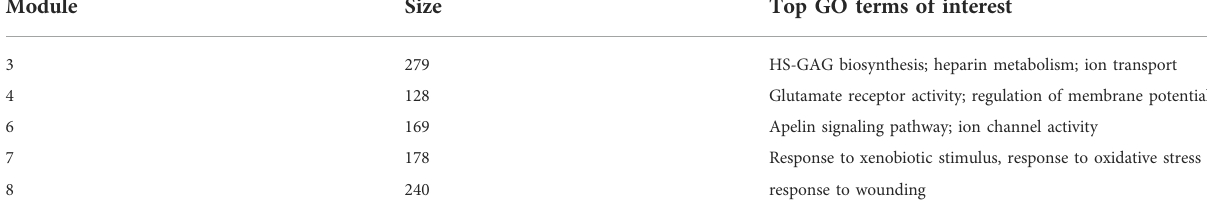
TABLE 3 Gene network module ID, number of genes, and top GO terms of interest for signi fi cantly enriched modules ( p < 0.05). Modules were selected based on size and signi fi cant functional enrichment.